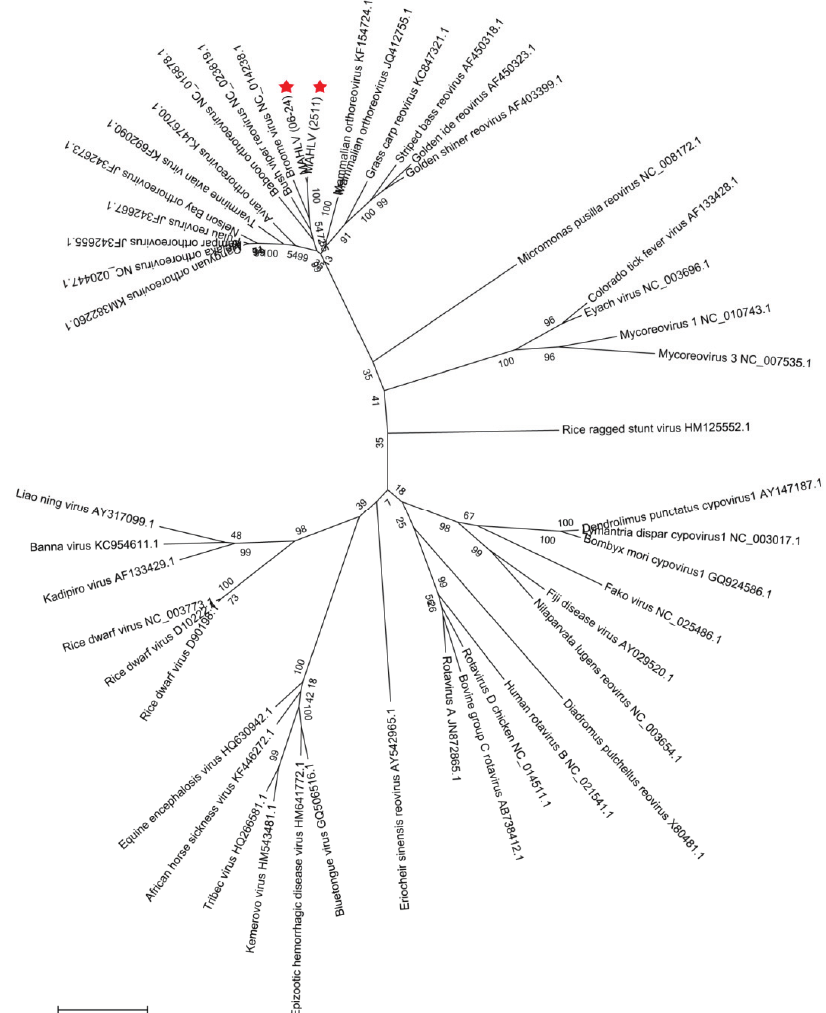
Figure 7. Molecular phylogenetic analysis by Maximum Likelihood method showing representative viruses from the Reoviridae family using the Lambda A (L1 segment) nucleic acid sequences. Genera to which the viruses belong are given in Table 1. The two MAHLV isolates are indicated by red stars and groups with other orthoreoviruses.